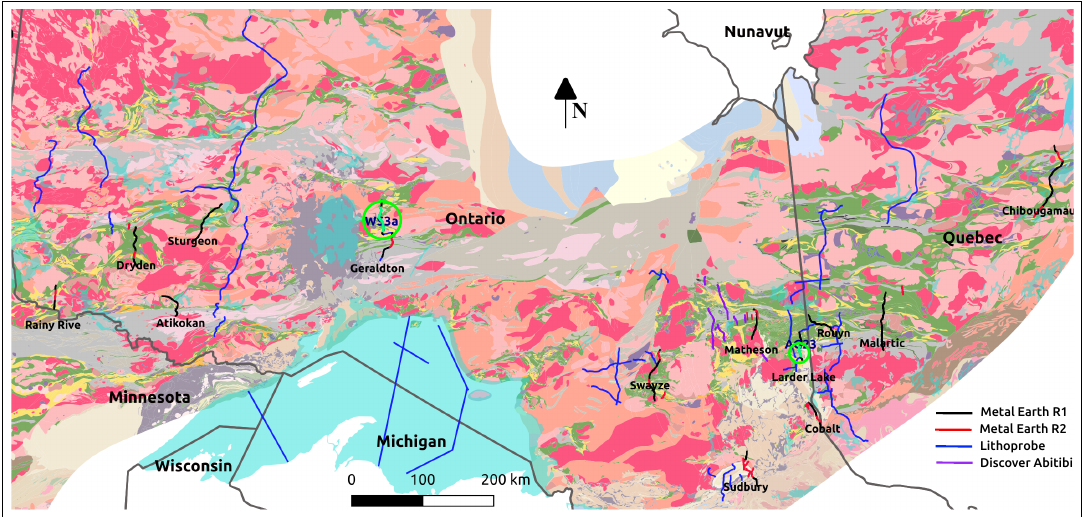
Figure 4. Location of the thirteen new Metal Earth transects, compared with previous Lithoprobe and Discover Abitibi profiles. The green lines, highlighted also by green circles, show the location of overlapped parts of Metal Earth and Lithoprobe